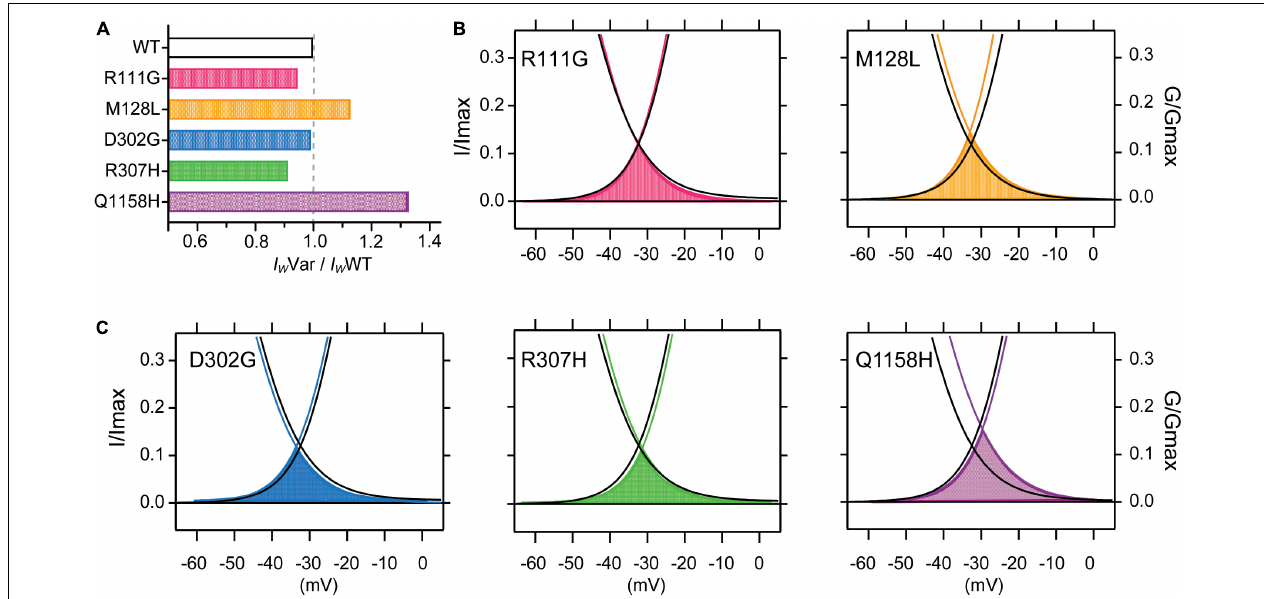
FIGURE 4 | Cav3.3-WT and HM-associated variant window currents. The window current ( I W ) was determined from the area under the overlapping normalized activation and inactivation curves (AUC) of WT and HM-associated Cav3.3 variants (average traces from Figures 2 , 3 ). (A) Total AUCs were divided by Cav3.3-WT AUC ( I W Var/ I W WT) for comparison. In (B,C) window currents are highlighted by the shading color corresponding to each HM-associated variant and plotted along Cav3.3 WT activation and SSI curves (in